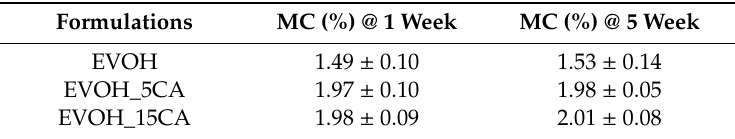
Table 5. Moisture content (MC) of EVOH based